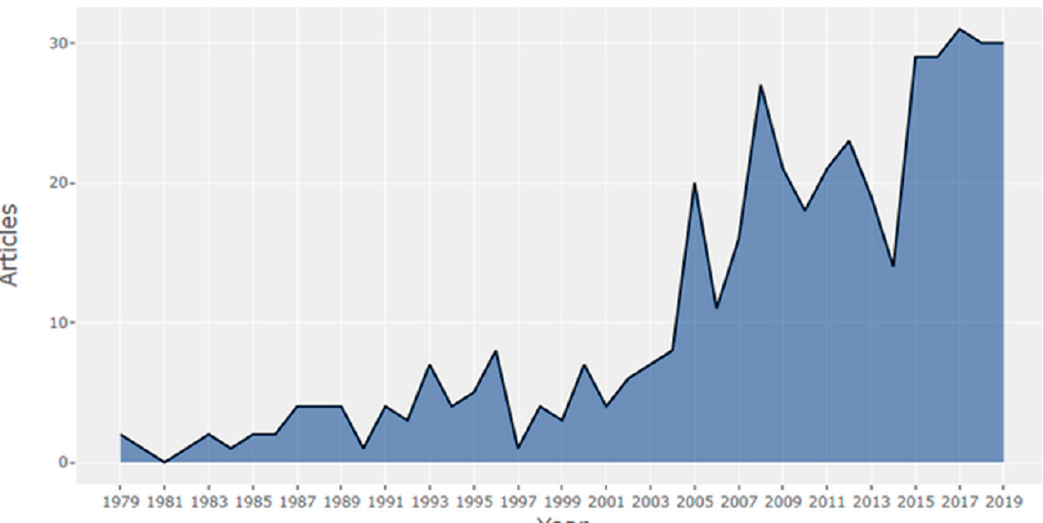
Figure 2. Annual scientific production on EOS and PM from 1979–2019.